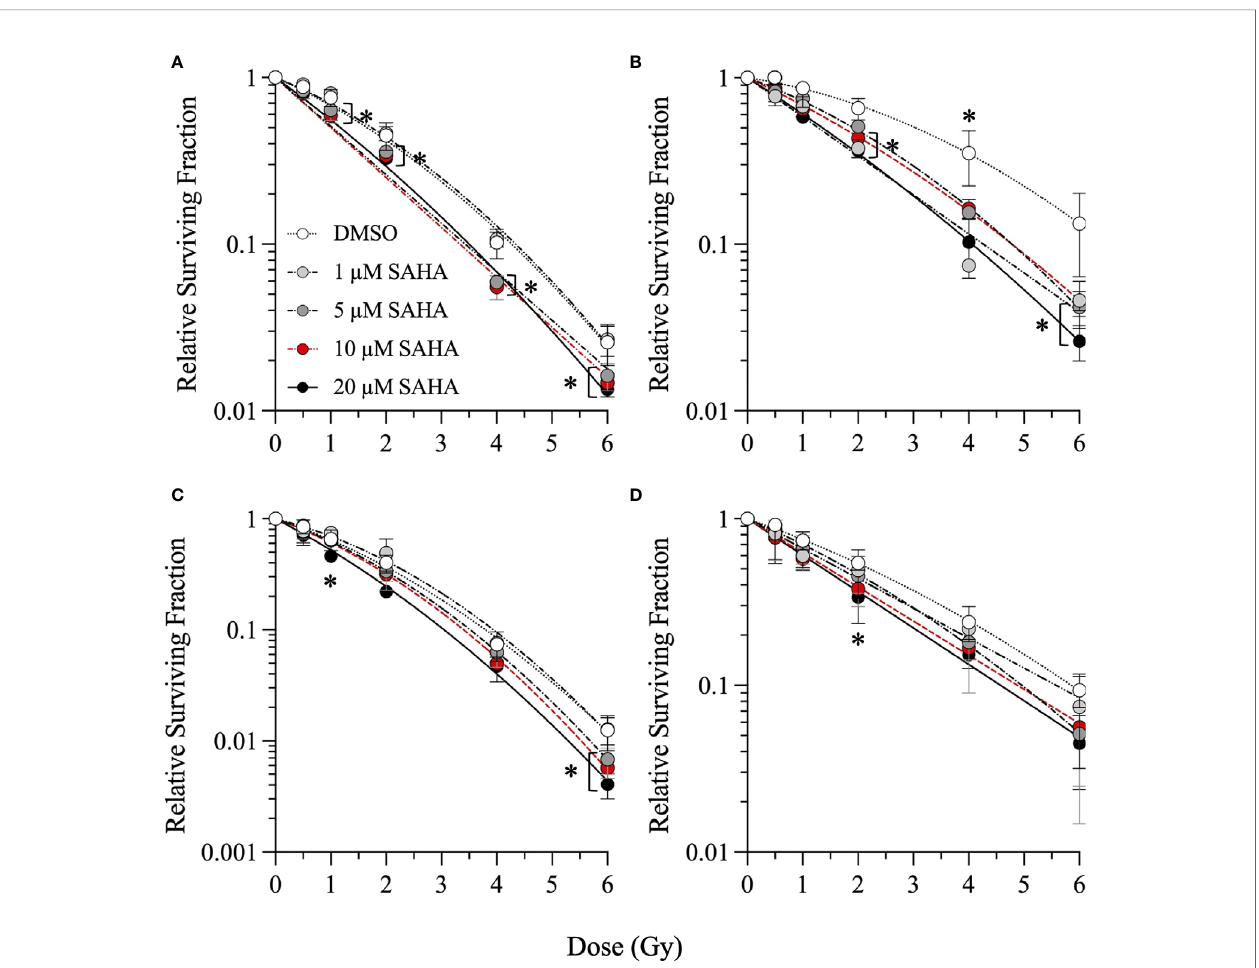
FIGURE 1 | Clonogenic survival of G0/G1-phase normal NFF28 primary fi broblasts (A) and asynchronously growing A549 lung carcinoma (B) , U2OS osteosarcoma (C) , and U87MG malignant glioma cells (D) pretreated for 18 h with 1 – 20 µM SAHA and exposed to 0.5 – 6 Gy cesium-137 g -rays (LET = 0.91 keV/µm). Data reported as mean ± SD; where error bars are not visible, they are smaller than the data point. Asterisks mark signi fi cant differences compared to DMSO controls at p -values of ≤ 0.05 (*) by one-way